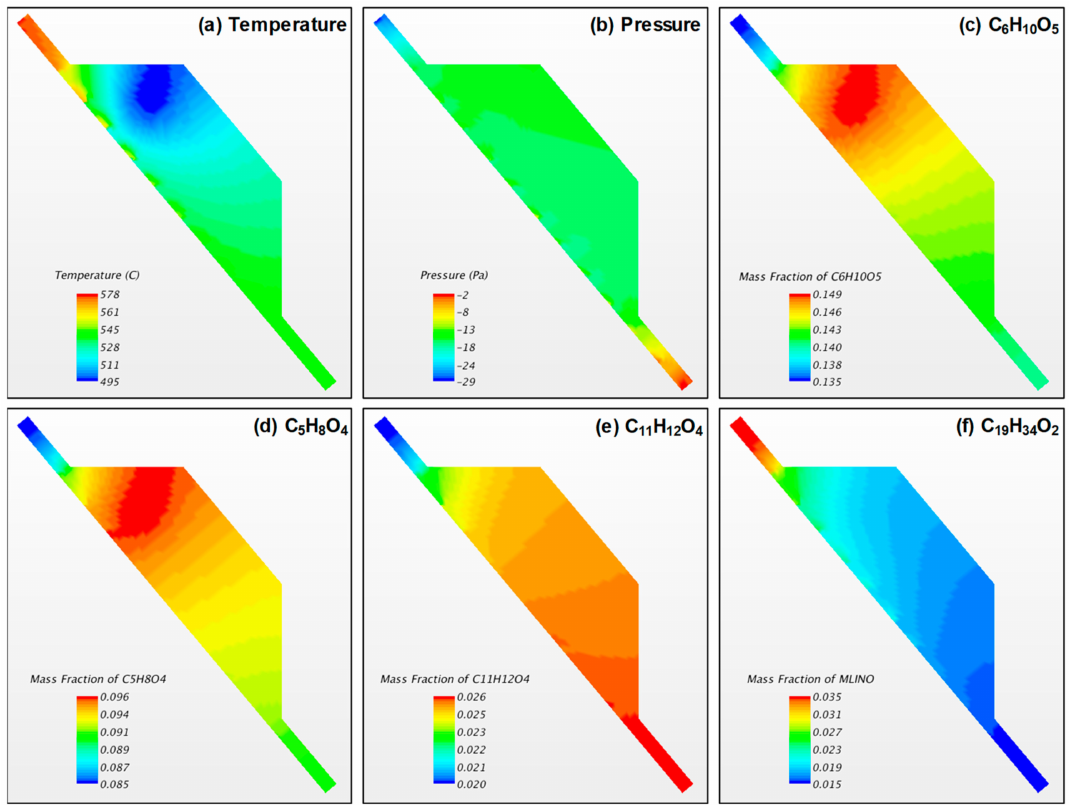
Figure 8. Temperature, pressure and mass fractions of major volatile species from cellulose, hemicellulose, lignin and extractives at the reactor temperature of 554 ◦